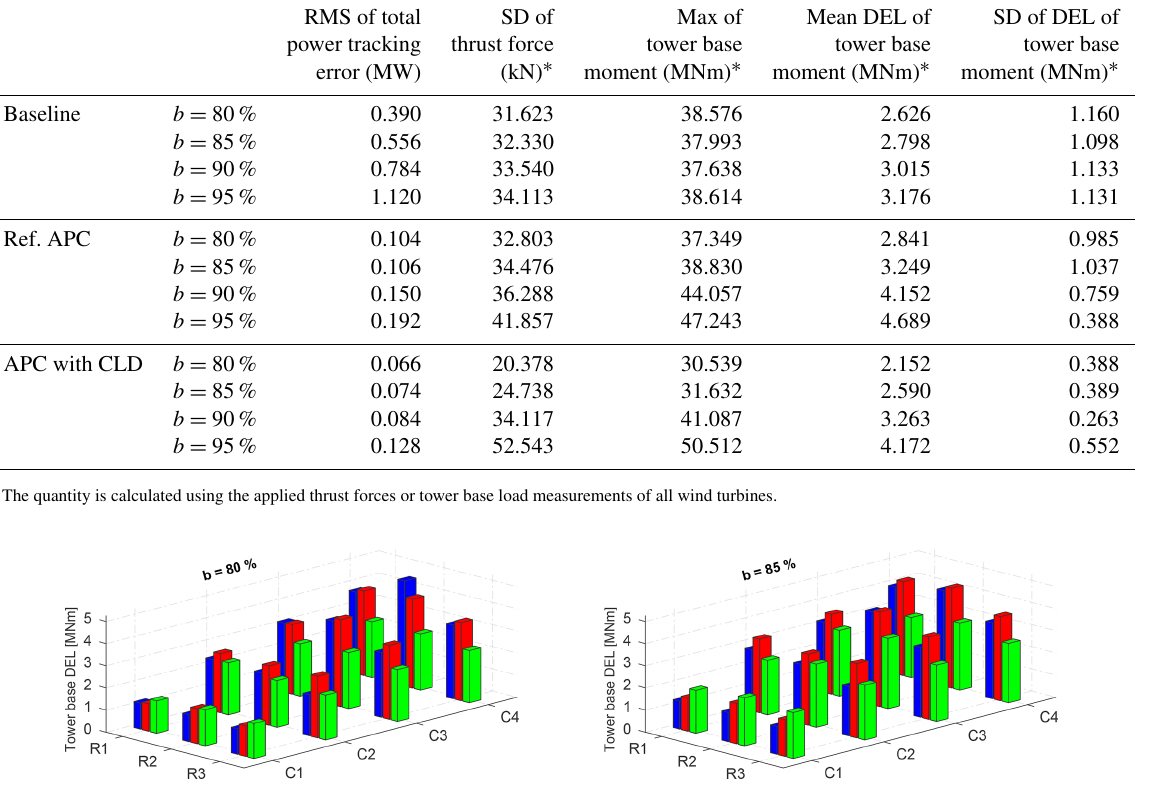
Table 4. Performance assessment of the studied APC approaches with PALM for different power reference parameterizations. The time- = 12 . 3MW, b = 80%, 85%, 90%, 95%, respectively, and c = 10%. All varying power references (Eq. 23) are parameterized as P base farm quantities are computed for the 30min time series (from 300 to 2100s) of the wind farm operation. RMS of total SD of Max of Mean DEL of SD of DEL of power tracking thrust force tower base tower base tower base error (MW) (kN) ∗ moment (MNm) ∗ moment (MNm) ∗ moment (MNm) ∗